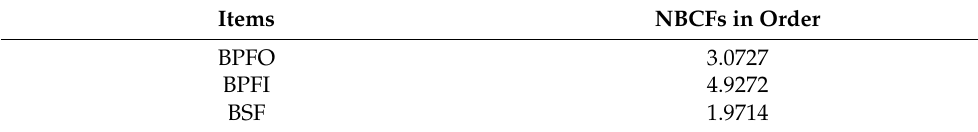
Table 2. NBCFs of the angular contact ball bearing.